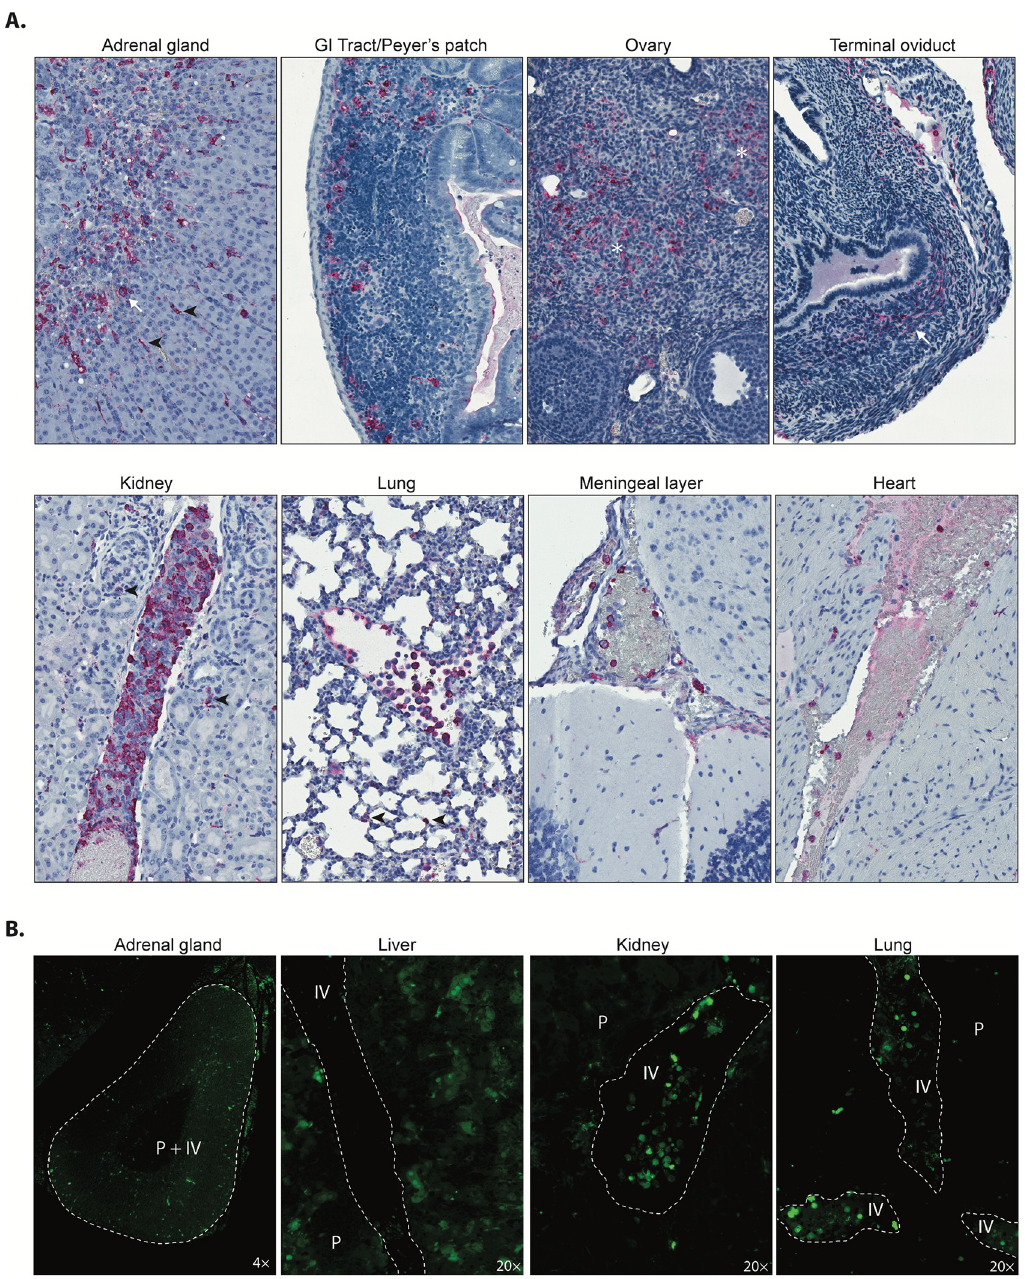
Fig 4. Distribution of viral NP antigen visualized by immunohistochemistry (IHC) in a CCHFV/ZsG-infected Ifnar − / − mouse at 6 dpi. (A) NP immunostaining in parenchymal and lymphoid tissues (top row). NP was visualized in epithelial cells (arrow) and endothelial/intravascular cells (arrowheads), most prominently at the adrenal corticomedullary junction, and scattered staining was seen in macrophages in gut-associated lymphoid tissue (Peyer’s patches). Focal staining was also observed in the ovarian medullary stroma ( ✱ ) and in the lamina propria of the terminal oviduct (arrow). NP immunostaining within intravascular leukocytes in various organs (bottom row). Increased intravascular leukocytes with abundant immunostaining were seen in kidney and lung, with rare staining of intracapillary leukocytes and interstitial cells (arrowheads). In the brain and heart, NP was detected in leukocytes within leptomeningeal vessels and in the lumen of the right heart ventricle. IHC: NP immunoalkaline phosphatase staining with naphthol fast red substrate, hematoxylin counterstain. Original magnification: 200 × . (B) ZsG fluorescence in embedded fixed issues. Parenchymal and intravascular ZsG signal for infected cells can be visualized without immunostaining using a fluorescent microscope: P = parenchyma (tissue); IV = intravascular; dotted line represents the boundary between the blood vessel and the surrounding tissue.